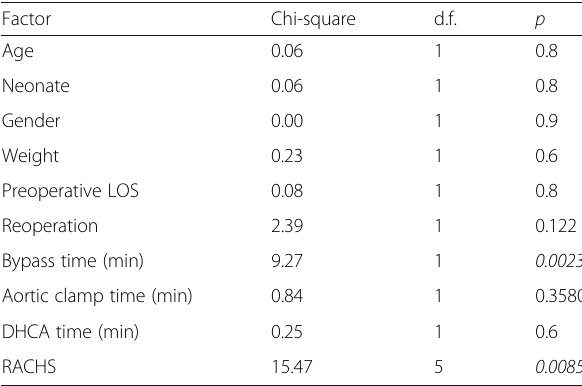
Table 2 Wald statistics of logistic regression, outcome: in- hospital death Factor Chi-square